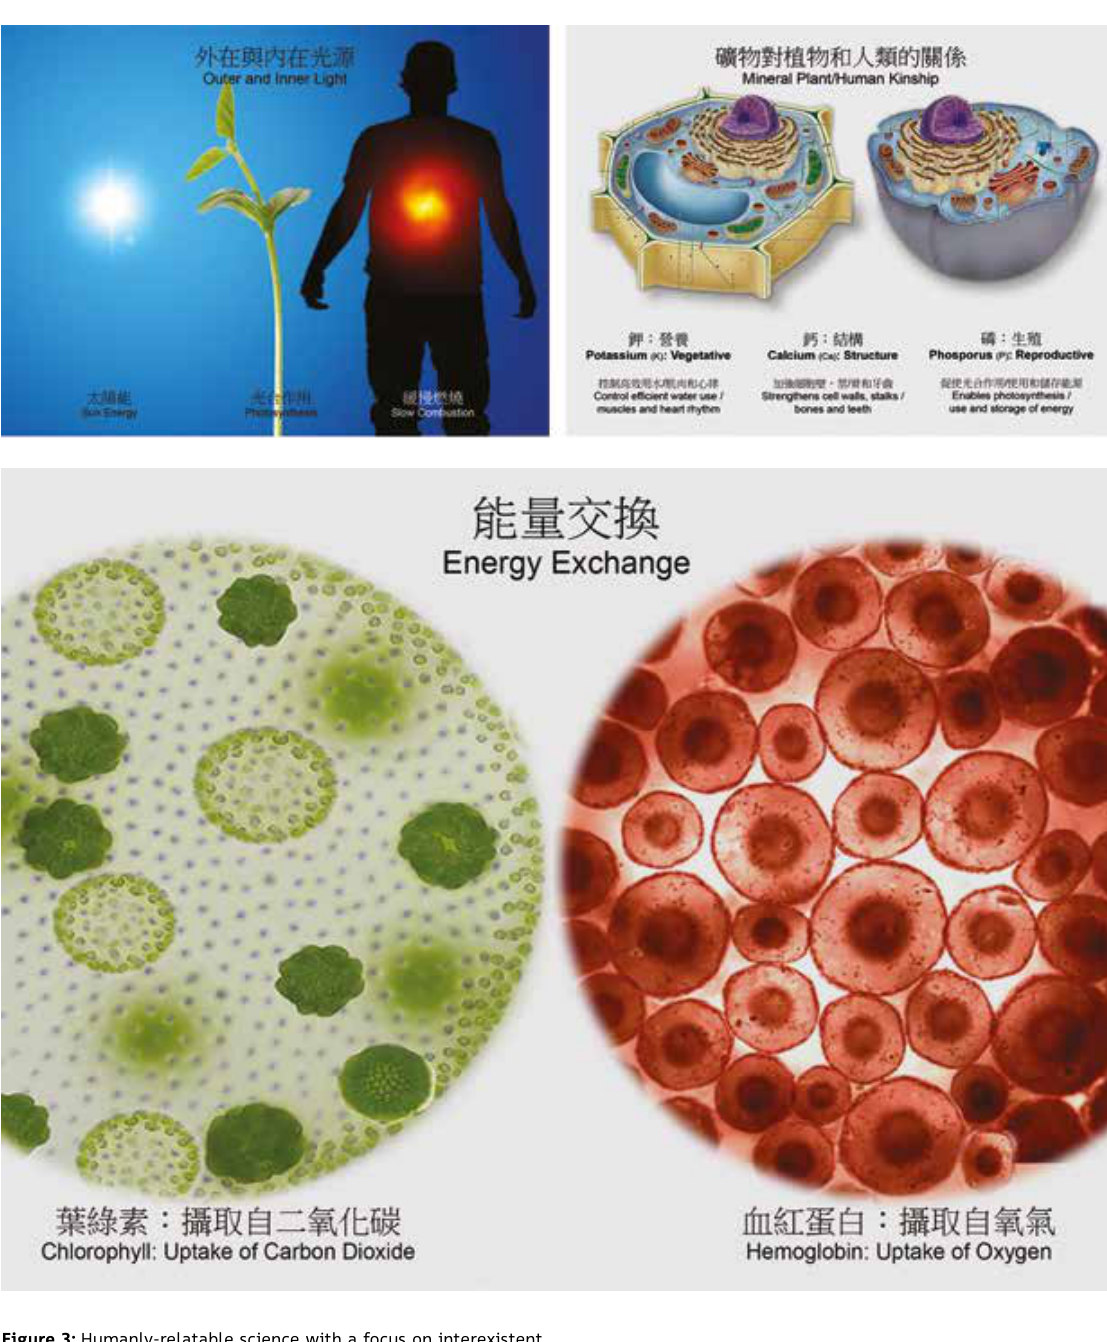
Figure 3: Humanly-relatable science with a focus on interexistent relations. Illustrations by the